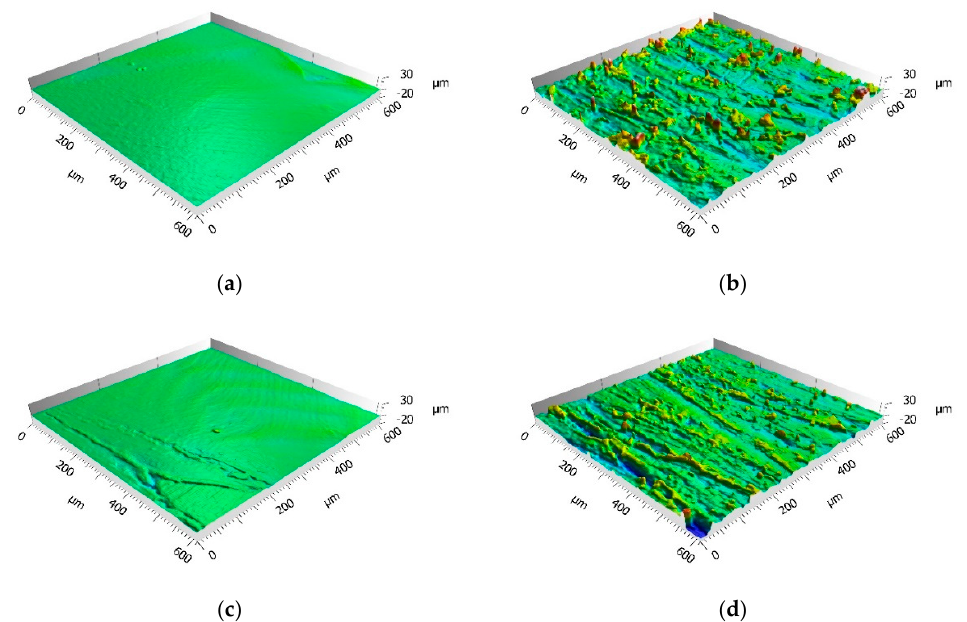
Figure 6. Example of the surface morphologies resulting from: ( a ) degreasing; ( b ) abrasion; ( c ) atmospheric pressure plasma treatment (APPT); D = 5 mm, v = 100 mm/s); ( d ) abrasion + APPT (D = 5 mm, v = 100 mm/s). Table 3. Average surface roughness, Sa, for the considered